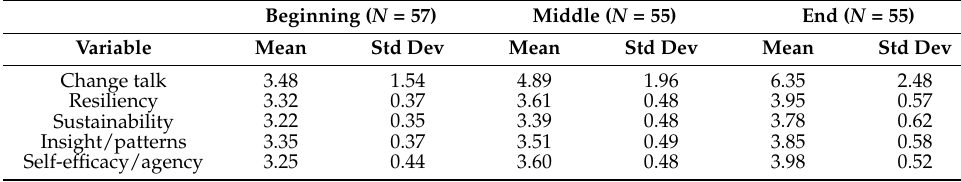
Table 2. Trends of the Outcome Measures Over 3 Time Points (mean (SD)).